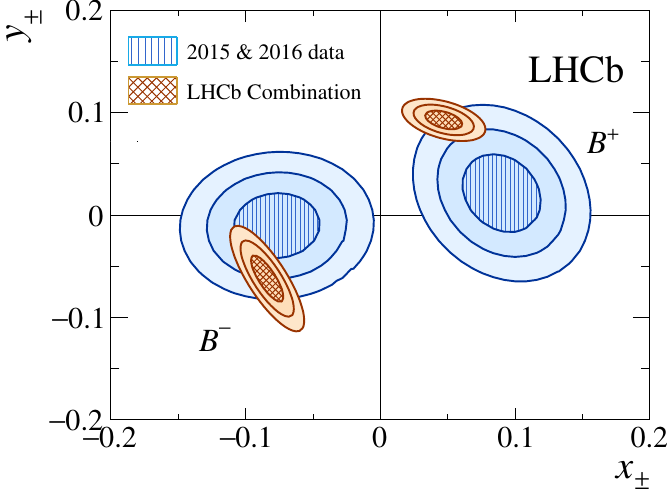
Figure 10 . Two-dimensional 68.3 %, 95.5 % and 99.7 % con(cid:12)dence regions for ( x (cid:6) ; y (cid:6) ) obtained in this measurement, as well as for the LHCb combination in ref. [54], taking statistical and systematic uncertainties, as well as their correlations, into